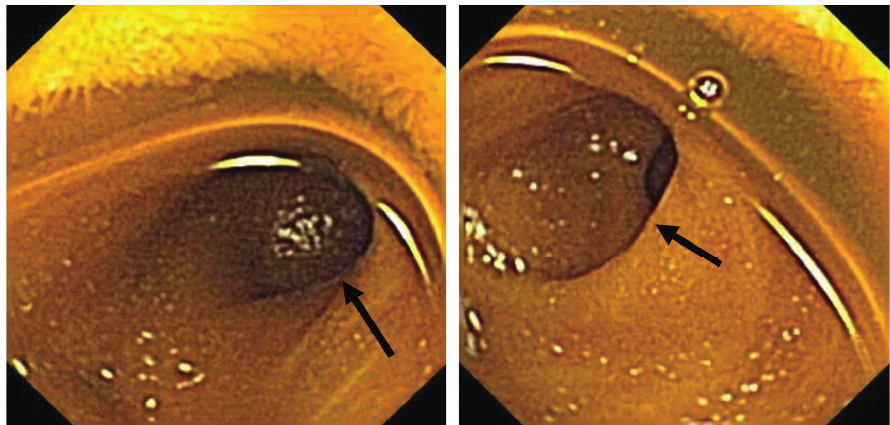
Figure 1: Video capsule endoscopy demonstrated a solitary diverticulum (indicated by black arrows) in the distal half of the ileum.